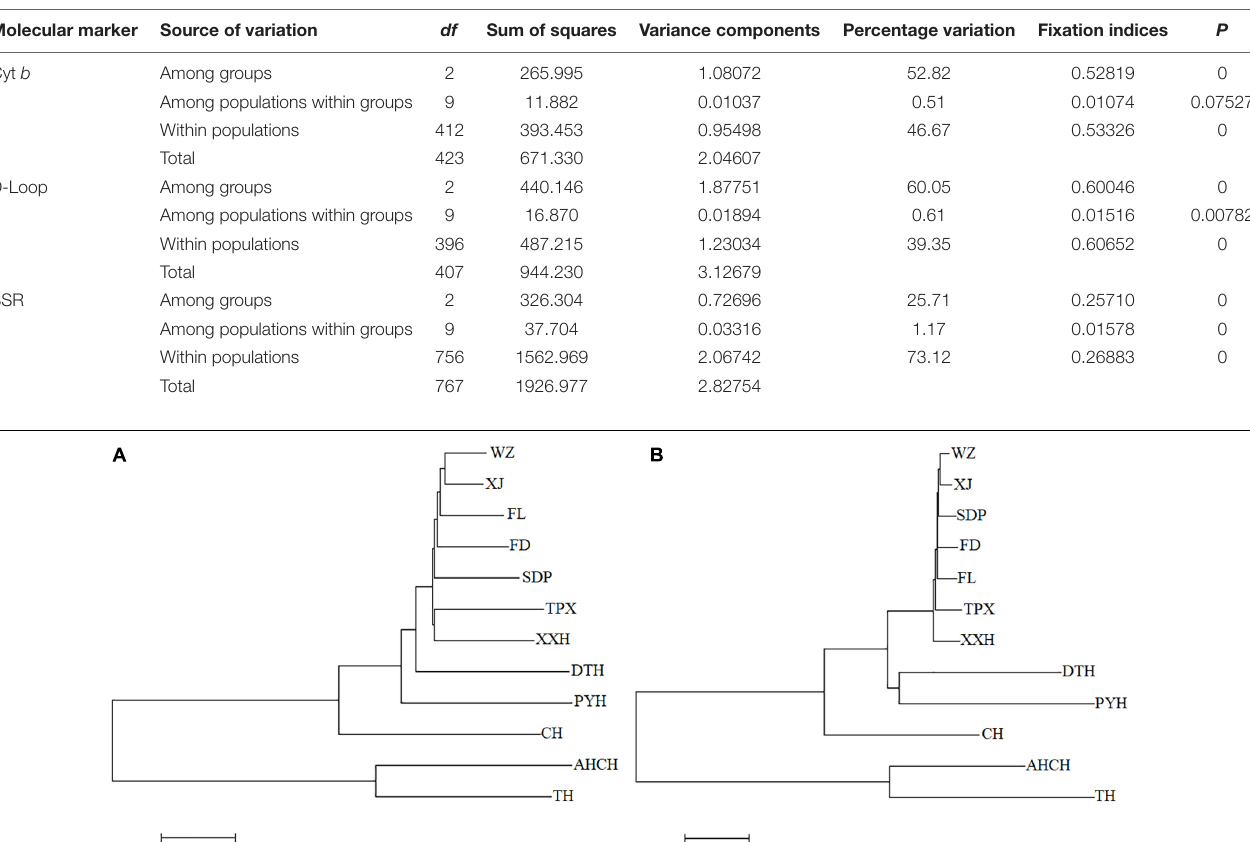
TABLE 3 | Analysis of molecular variance (AMOVA) for 12 C. brachygnathus populations based on mtDNA and SSR analyses. Molecular marker Source of variation df Sum of squares Variance components Percentage variation Fixation indices